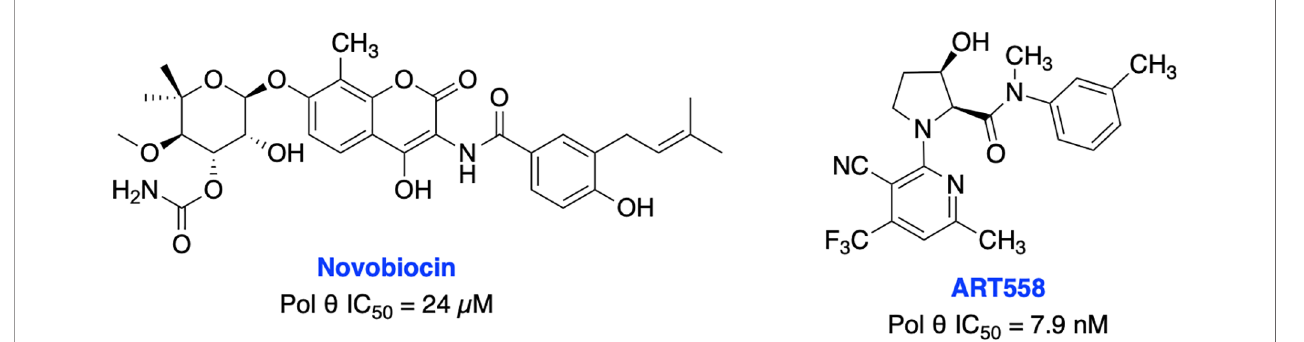
FIGURE 13 | Small molecule inhibitors targeting Pol q with their respective IC50 values for inhibition of polymerase activity.